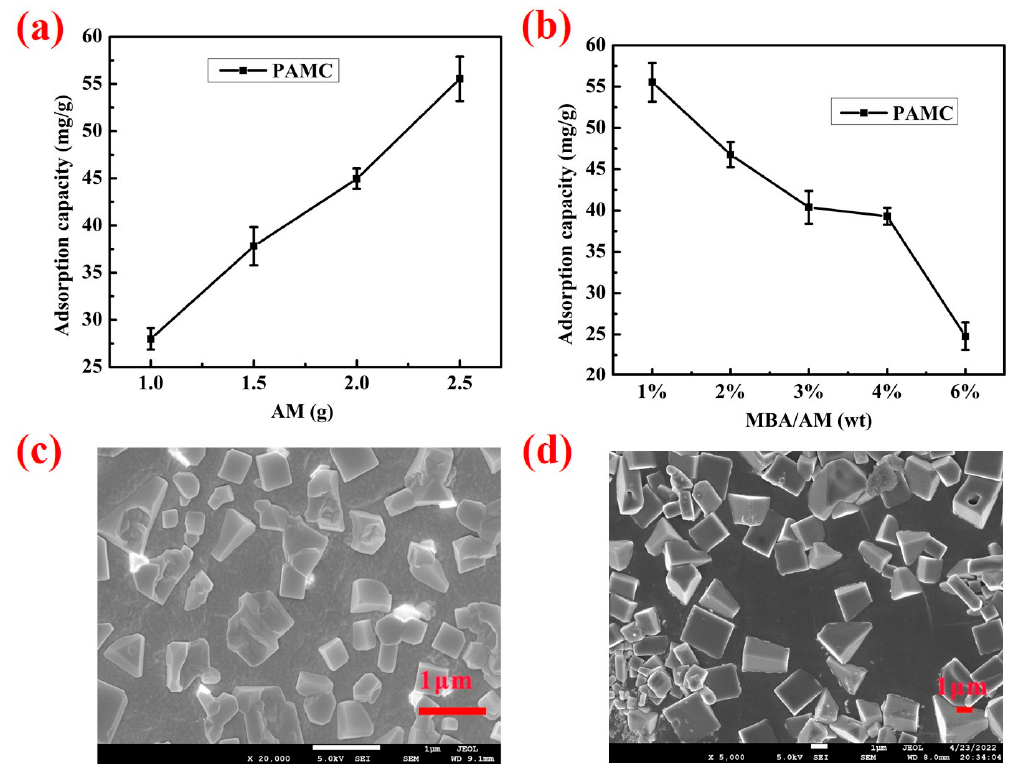
Figure 5. Effect factors of adsorption capacity of PAMC: ( a ) AM content; ( b ) MBA content; ( c ) surface morphology; and ( d ) internal morphology of PAMC-1 absorbed in